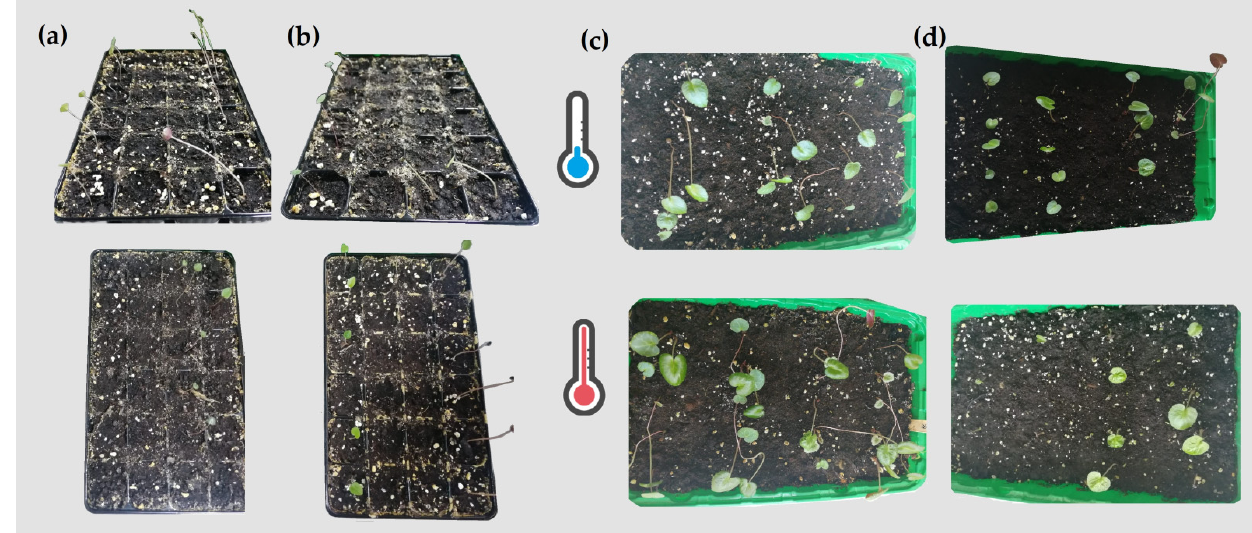
Figure 4. Germination capacity ( a,b ) and plant development ( c,d ) of heat-resistant C15 ( upper left-a ) and heat-sensitive C2 ( upper right-b ) under ambient temperature or heat stress.